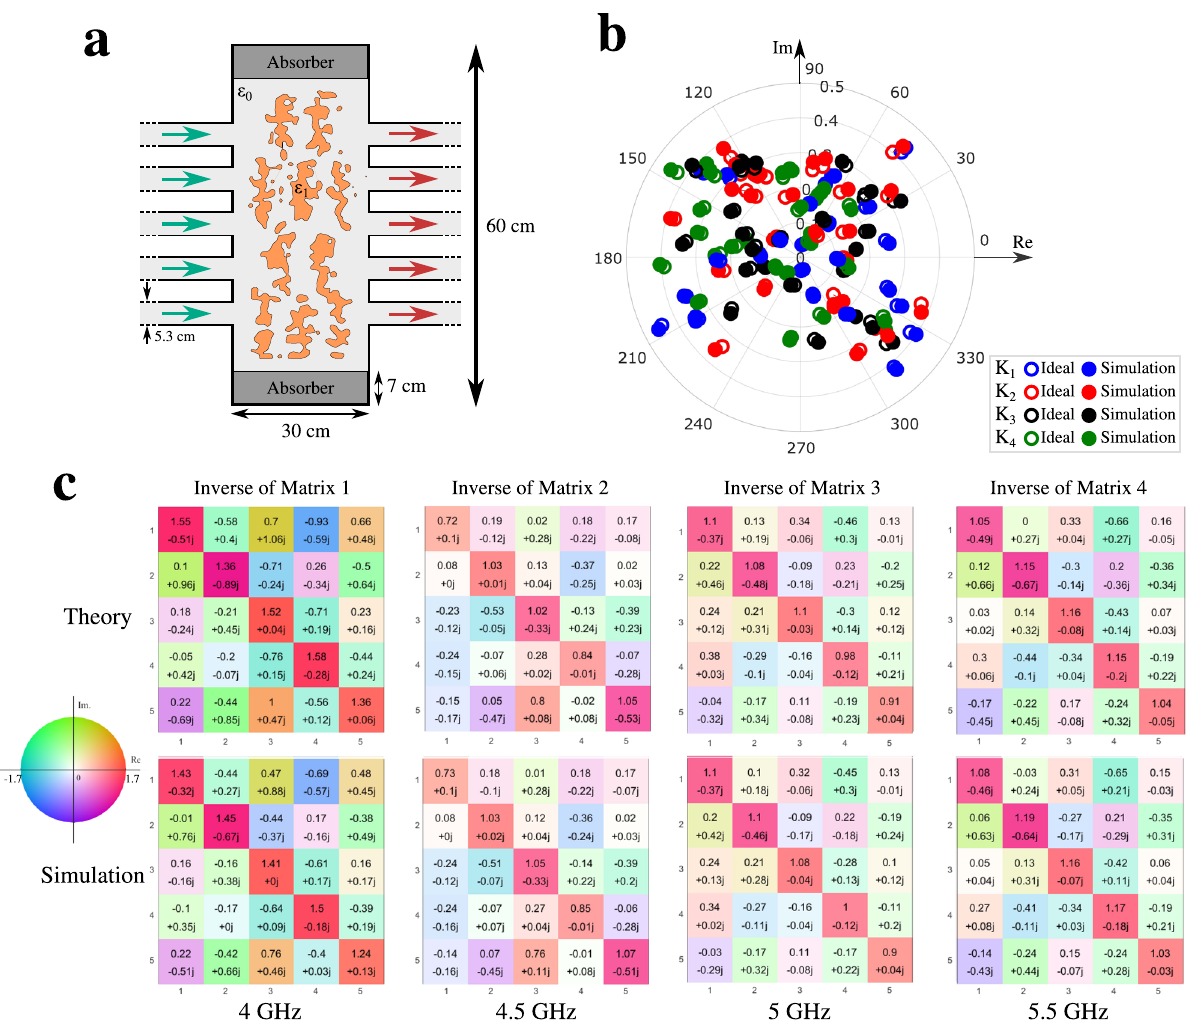
Fig. 3 Simulated design for a single metamaterial device that can invert four matrices simultaneously, designed at four different frequencies. a Dielectric distribution designed for the four selected matrices. b Comparison between the simulation results of our design for the transmission s- parameters of 4 matrices at the four frequencies of interest, and the corresponding desired values of these kernels. c Theoretically expected and the simulation results for the inverse matrices achieved using the designed